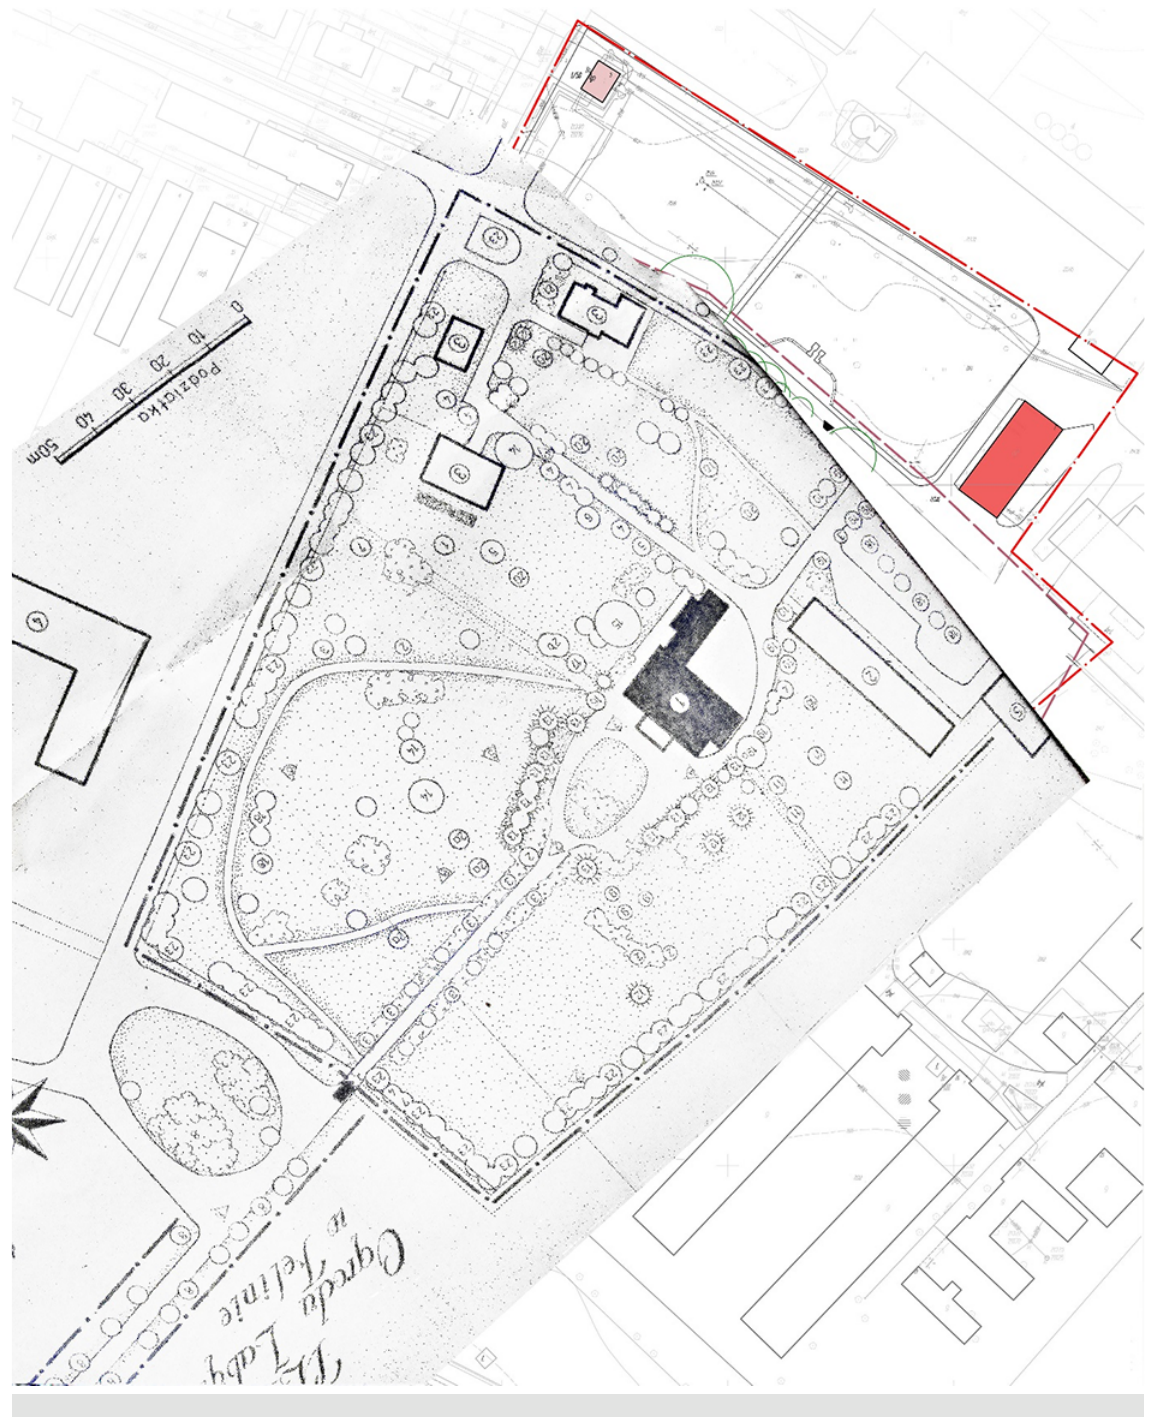
Fig. 1 The Felin Manor Park – inventory map from 1981 imposed on a contemporary situational map